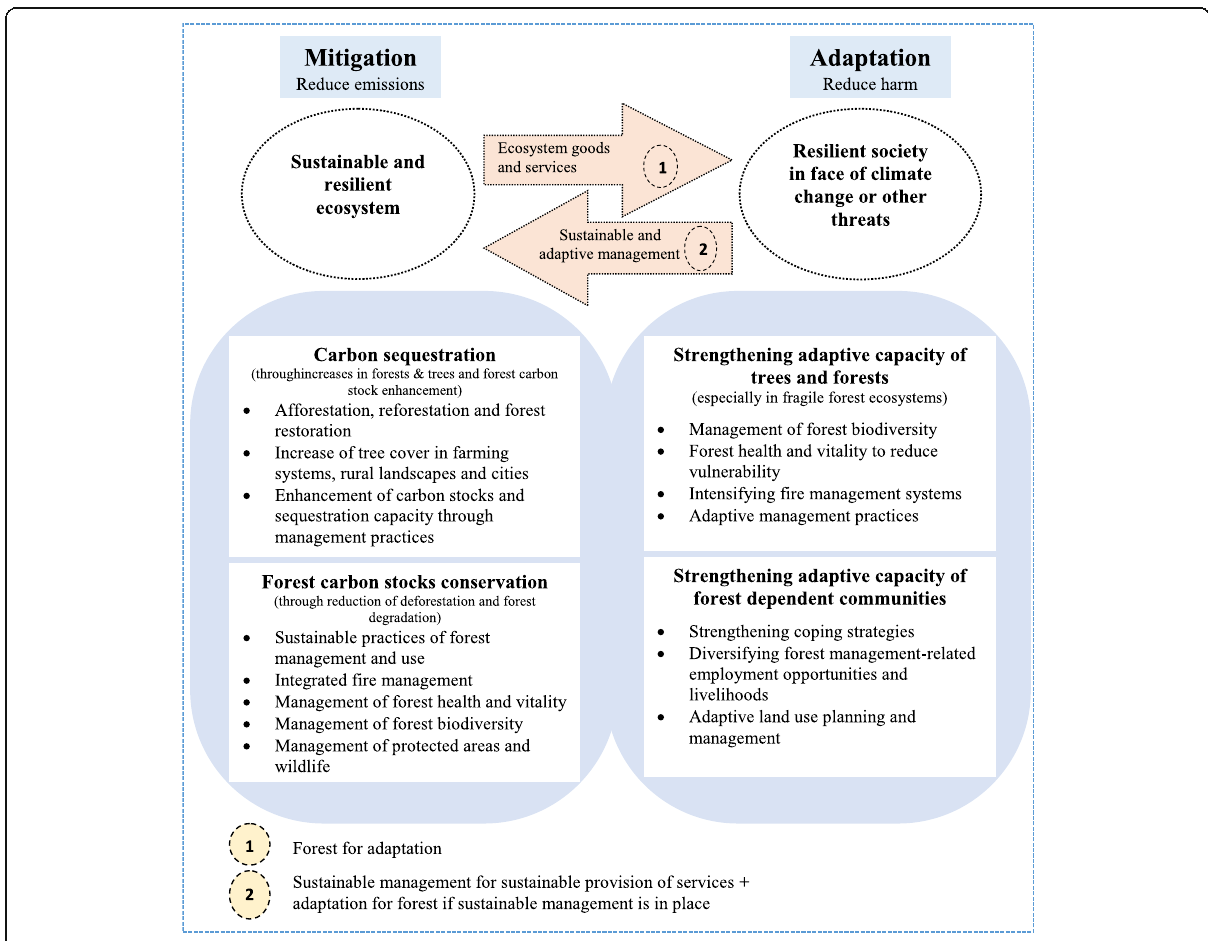
Fig. 3 Mechanisms showing how forest management helps tackle climate change (Source: Adapted from FAO